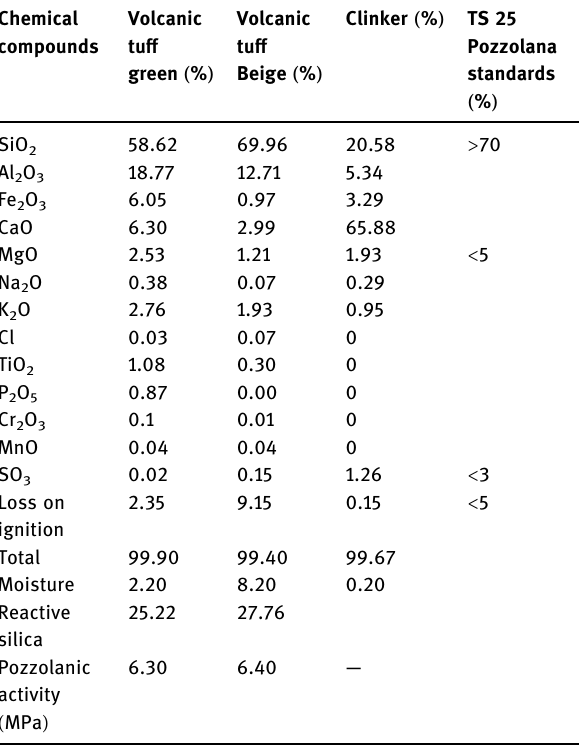
Table 1: Chemical compositions of the materials Chemical compounds